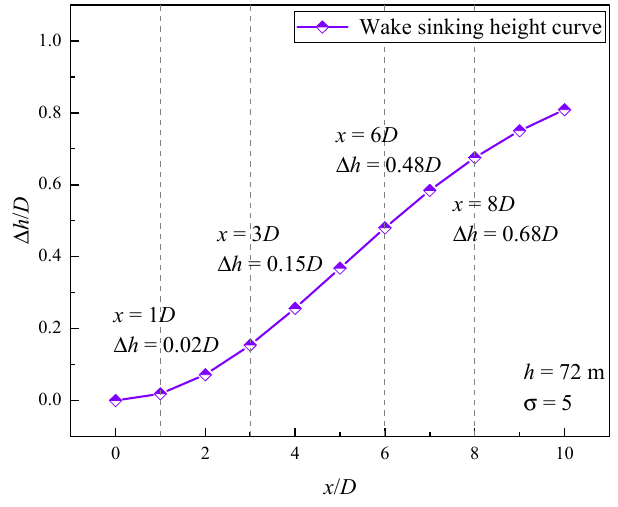
Figure 6. Wake sinking height curve.